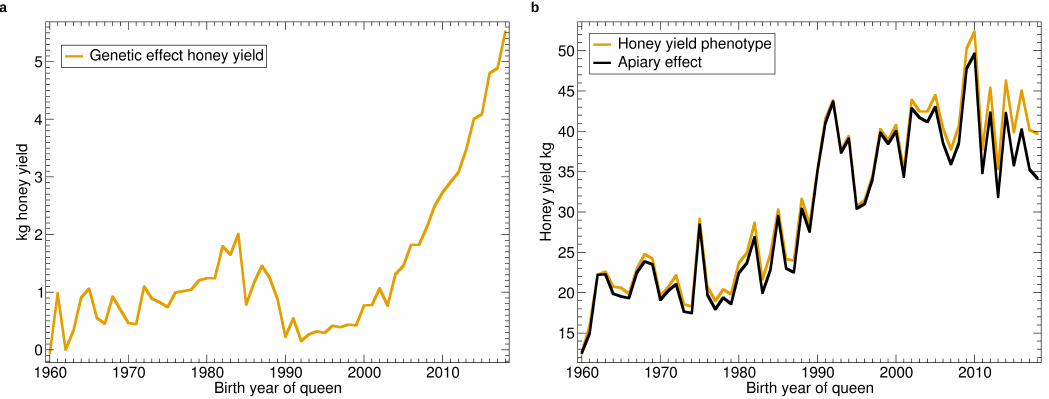
Figure 3. Yearly averages of honey yield: ( a ) Progression of the genetic effect. ( b ) Progression of the average apiary effect and phenotype as the sum of genetic and apiary